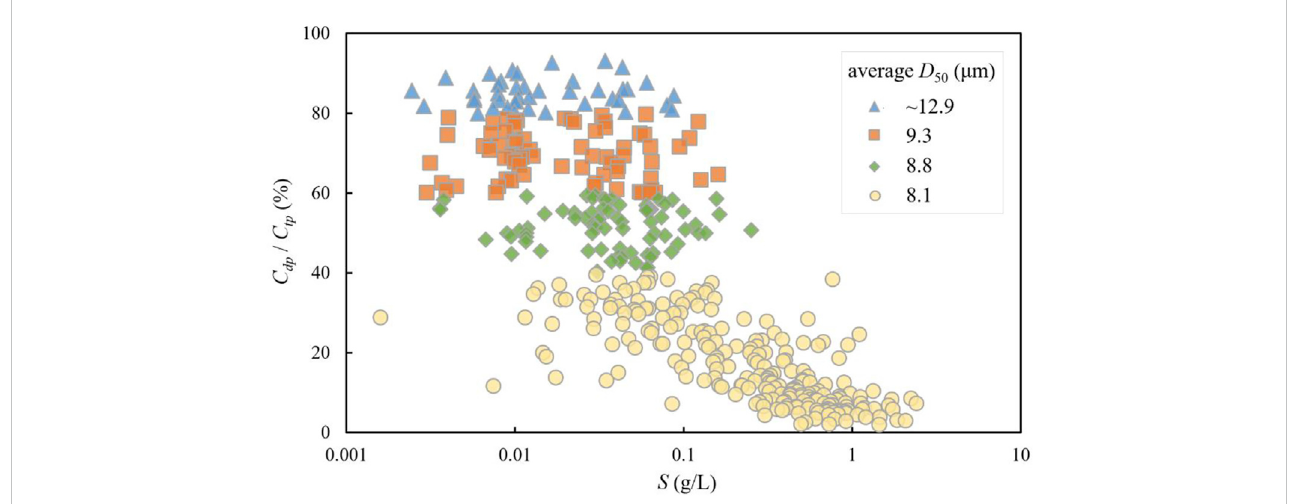
FIGURE 5 TheproportionofdissolvedP( C dp / C tp ) versus sedimentconcentration( S )basedonthemeasureddatacollectedfromtheThreeGorgesReservoirareaof theYangtzeRiver (2004 – 2012 and 2015 – 2016). Different symbols represent arti fi cial groups with C dp / C tp of 80% – 100%, 60% – 80%, 40% – 60% and 0% – 40%, respectively.